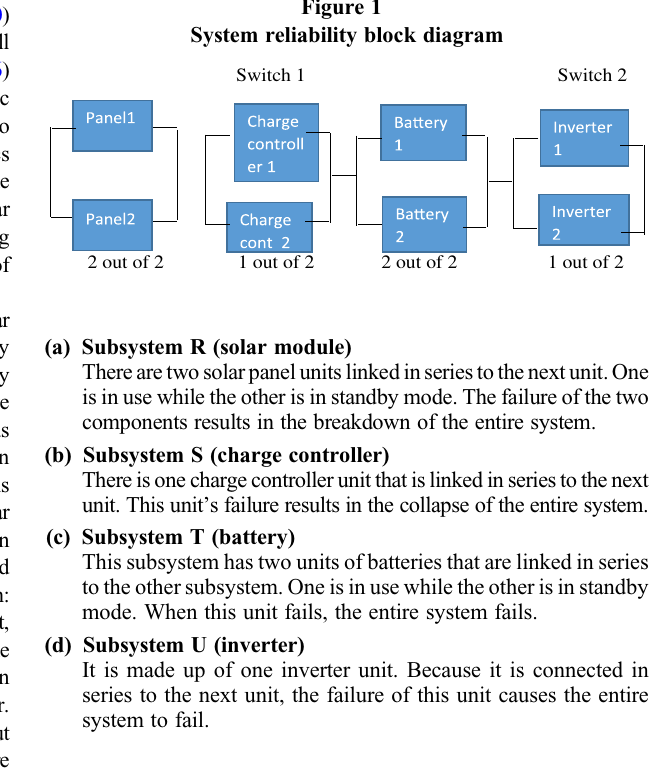
System reliability block